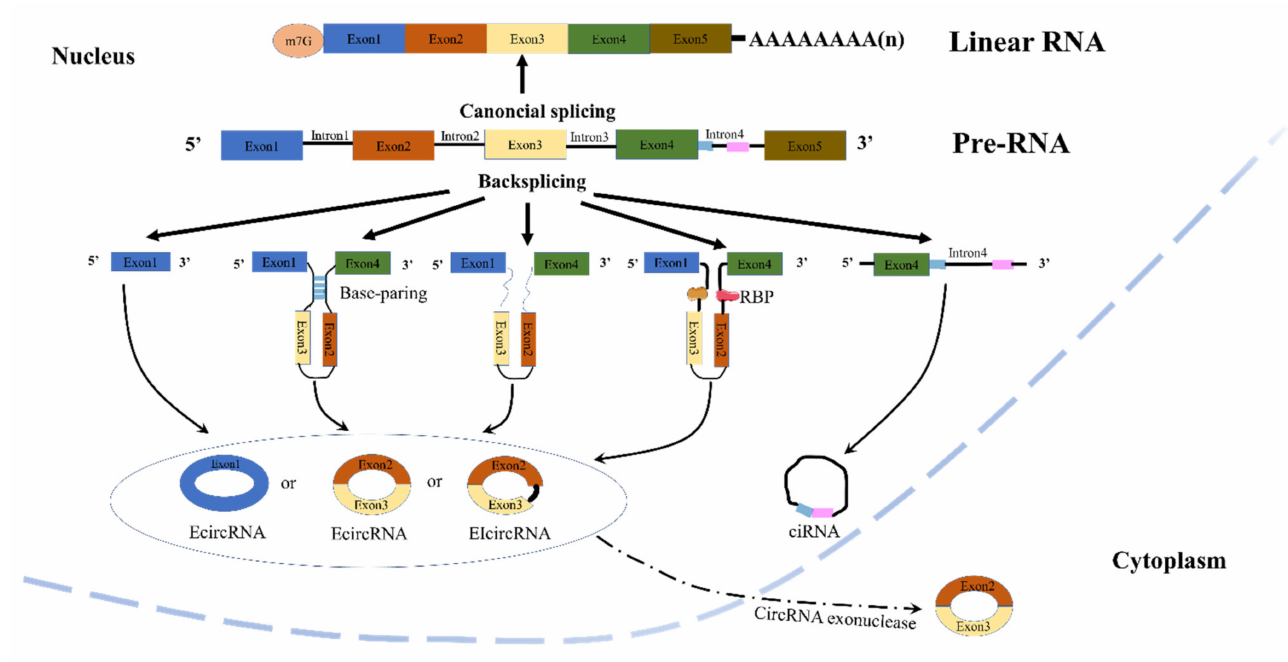
Figure 1. Biogenesis and classification of circRNAs.